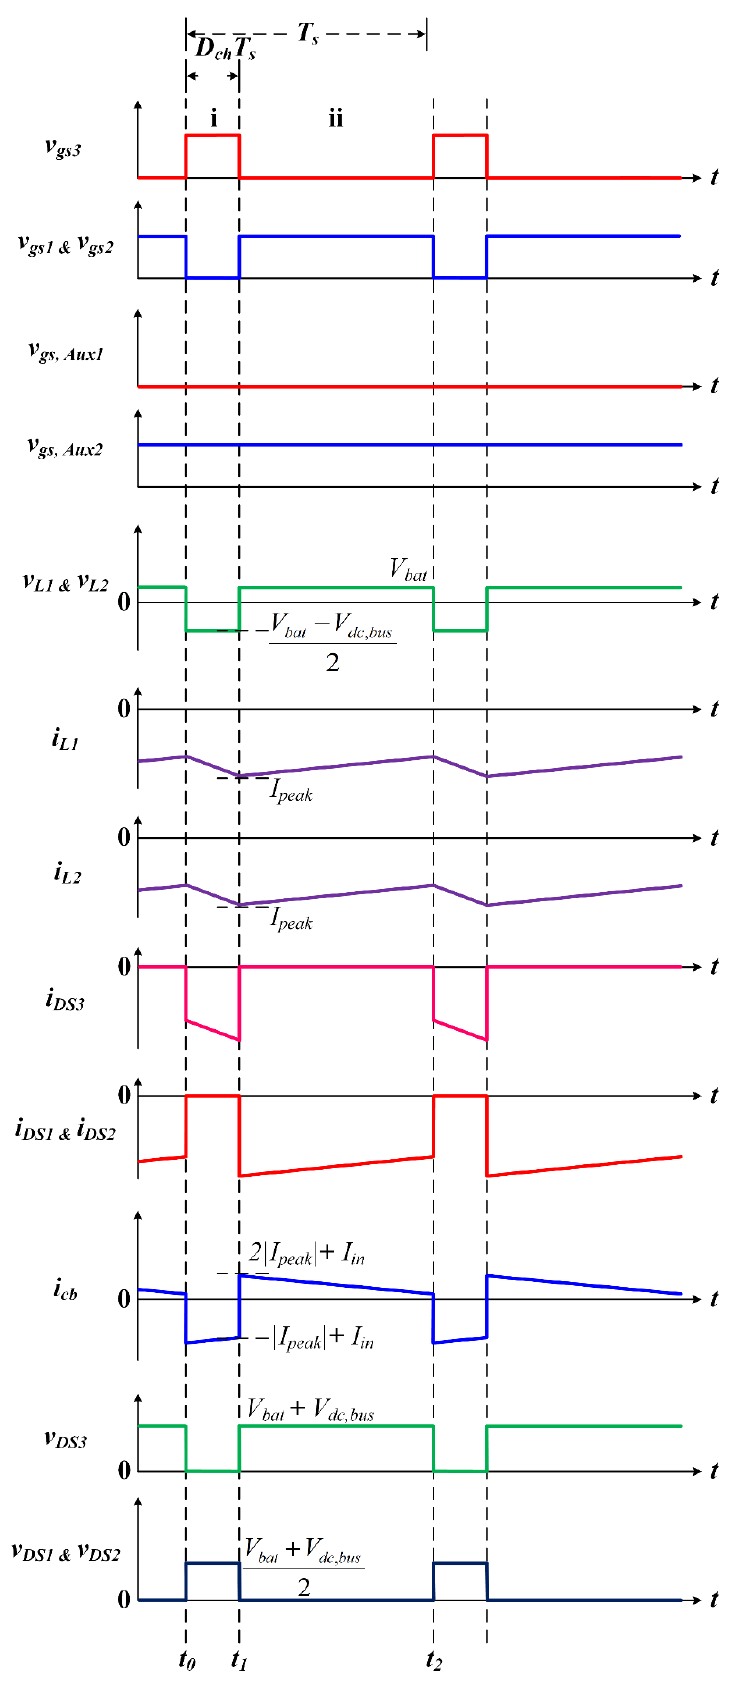
Figure 4. The waveforms of the step-down mode.